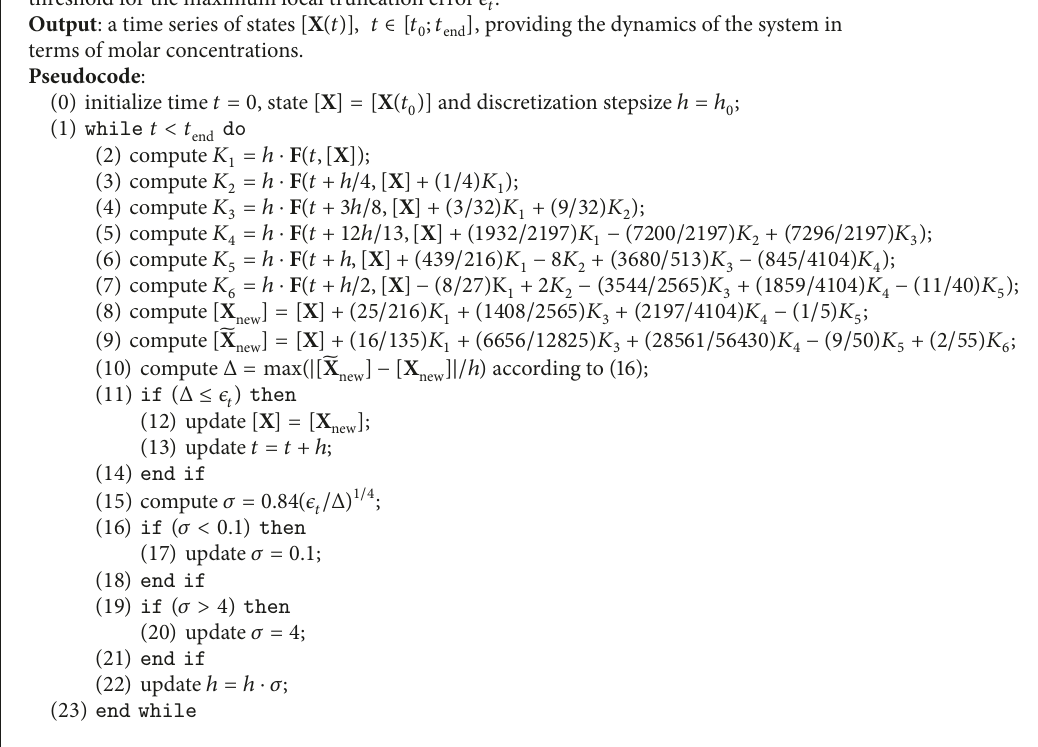
Algorithm 4: The Runge-Kutta Fehlberg (RK45)